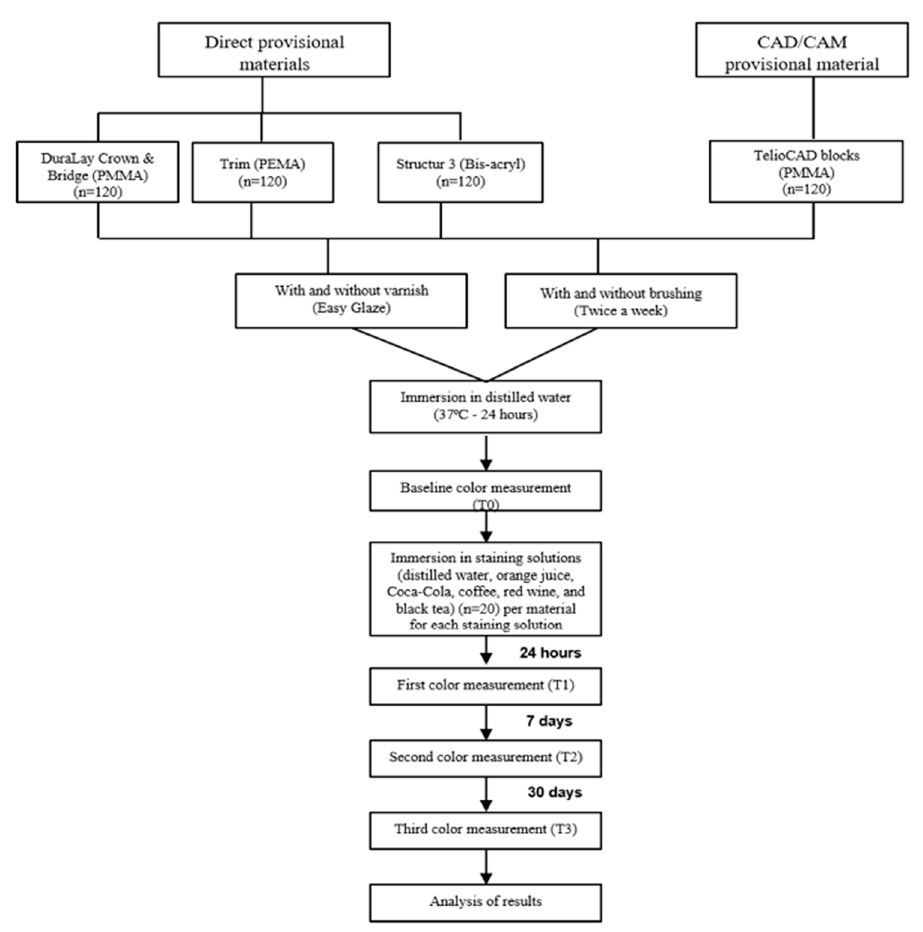
Figure 1. Diagram of the study design. Table 2. Staining solutions used in the